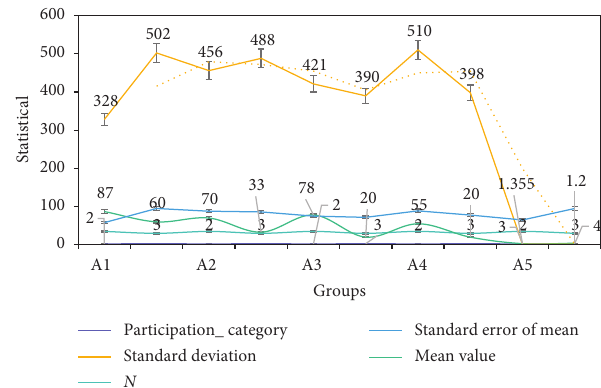
Figure 1: Statistical quantity of groups statistical